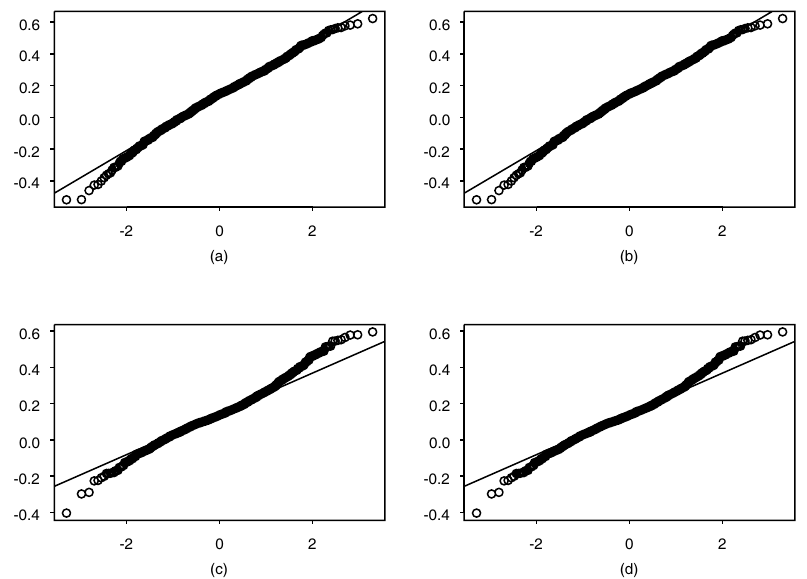
Figure 4 – Plot ( , ) x y of the quantiles of the standard normal distribution ( x -axis) and the corre- sponding sample values of the linear approximation (4) ( y -axis), sample size 4 n (cid:32) (panel (a)) and 7 n (cid:32) (panel (c)). Plot ( , ) x y of the quantiles of the standard normal distribution ( x -axis) and the sample values of the higher-order linear approximation (5) ( y -axis), sample size 4 n (cid:32) (panel (b)) and 7 n (cid:32) (panel (d)). The ratio of means example, with bivariate lognormal observations from cor- related ( 0.377541 (cid:85) (cid:32) )